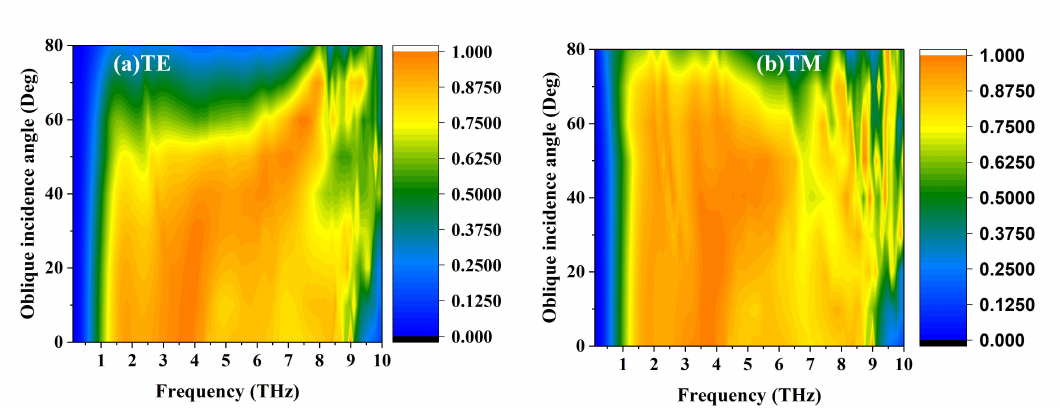
Figure 11. Absorption contour map of the absorber under various incident angles ( a ) TE mode and ( b ) TM